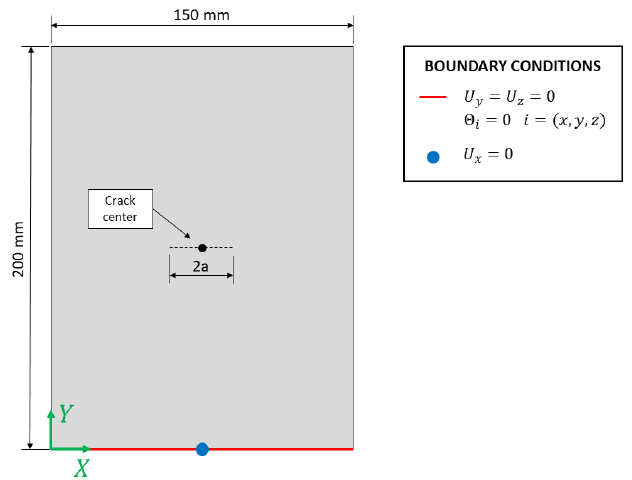
Figure 10. iFEM model with boundary conditions and the crack center positions.